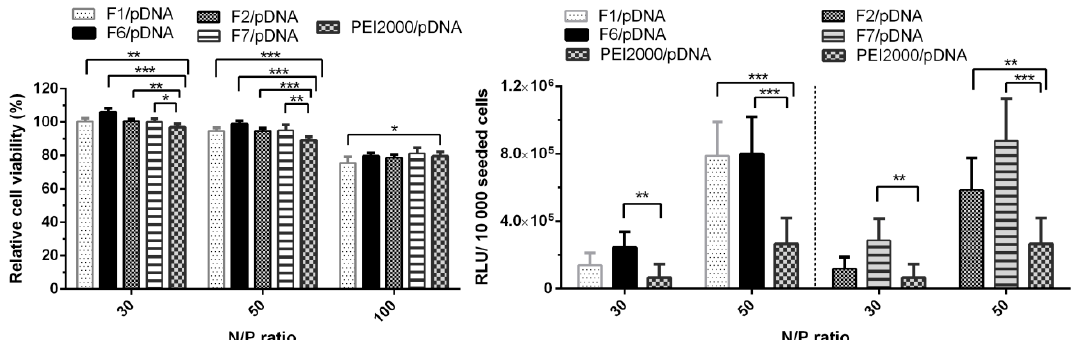
Figure 7. Graphical representation of relative viability and transfection e ffi ciency (relative light units (RLUs) / 10,000 seeded cells) of Hela cells treated with polyplexes at 30, 50 and / or 100 N / P ratios. The results are presented as a mean value ± the standard deviation (S.D.), n = 5–7. * p < 0.05, ** p < 0.01, and *** p < 0.001 by Student’s t